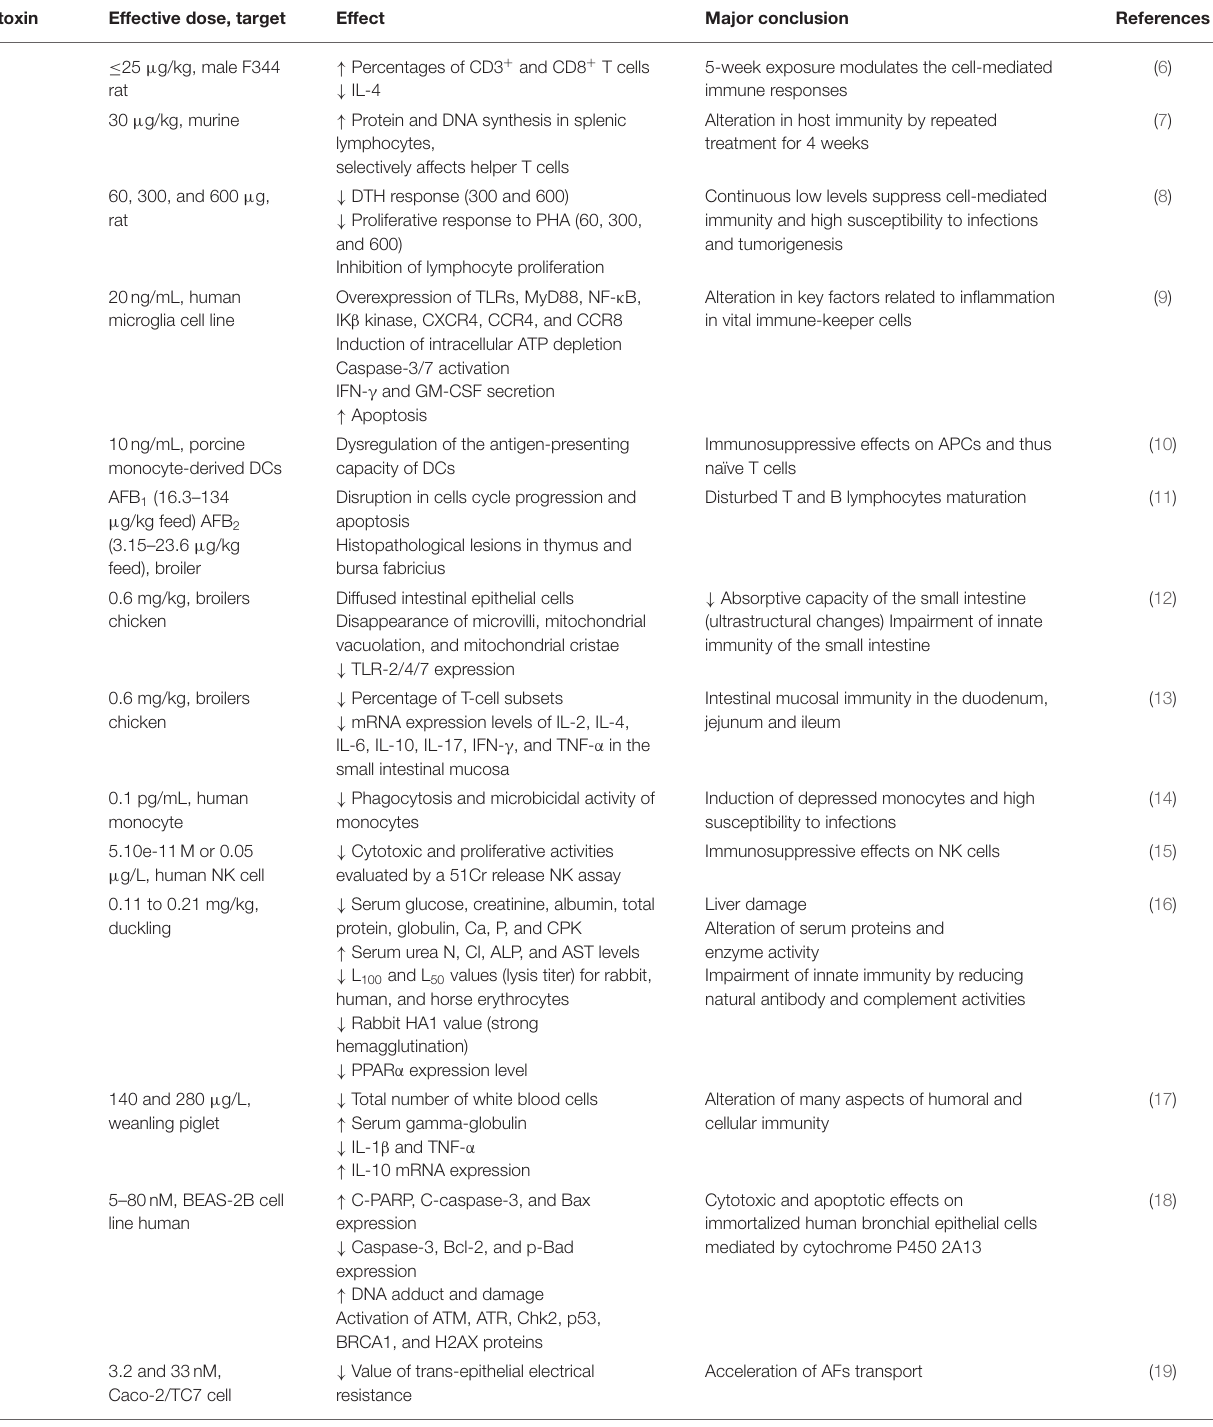
TABLE 1 | The metabolic and immune shifts induced by mycotoxins (focusing on low concentrations).